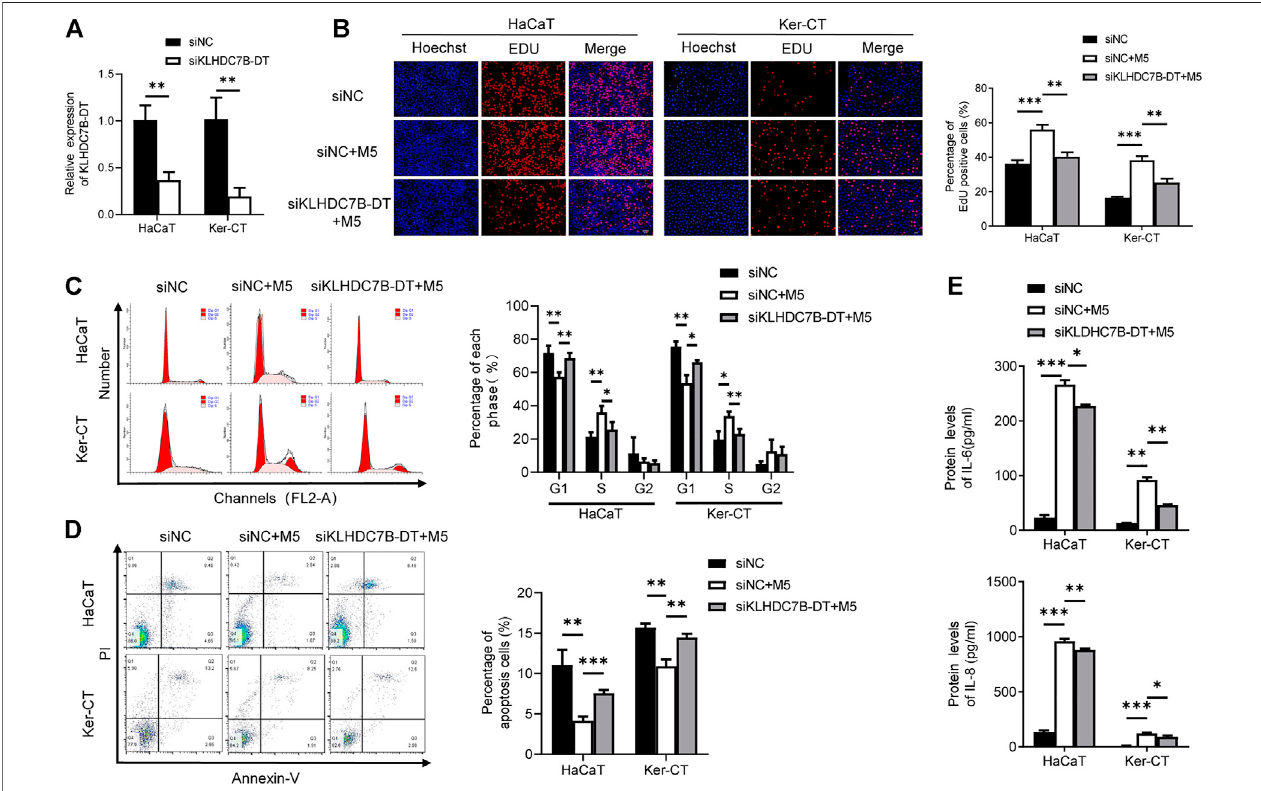
FIGURE 2 | KLHDC7B-DT regulates proliferation and in fl ammatory factor secretion in M5-induced keratinocytes. (A) The ef fi ciency of KLDHC7B-DT knockdown was detected by qRT – PCR. (B) Proliferative effects were detected by EdU assay. (C) The cell cycle was detected by fl ow cytometry through PI staining. (D) Cell apoptosiswasdetectedby fl owcytometrythroughAnnexin-V/PIstaining. (E) ProteinlevelsofIL-6andIL-8weredetectedbyELISA.Dataareshownasthemeans±SD, * p < 0.05, ** p < 0.01, *** p < 0.001. All experiments were repeated at least three